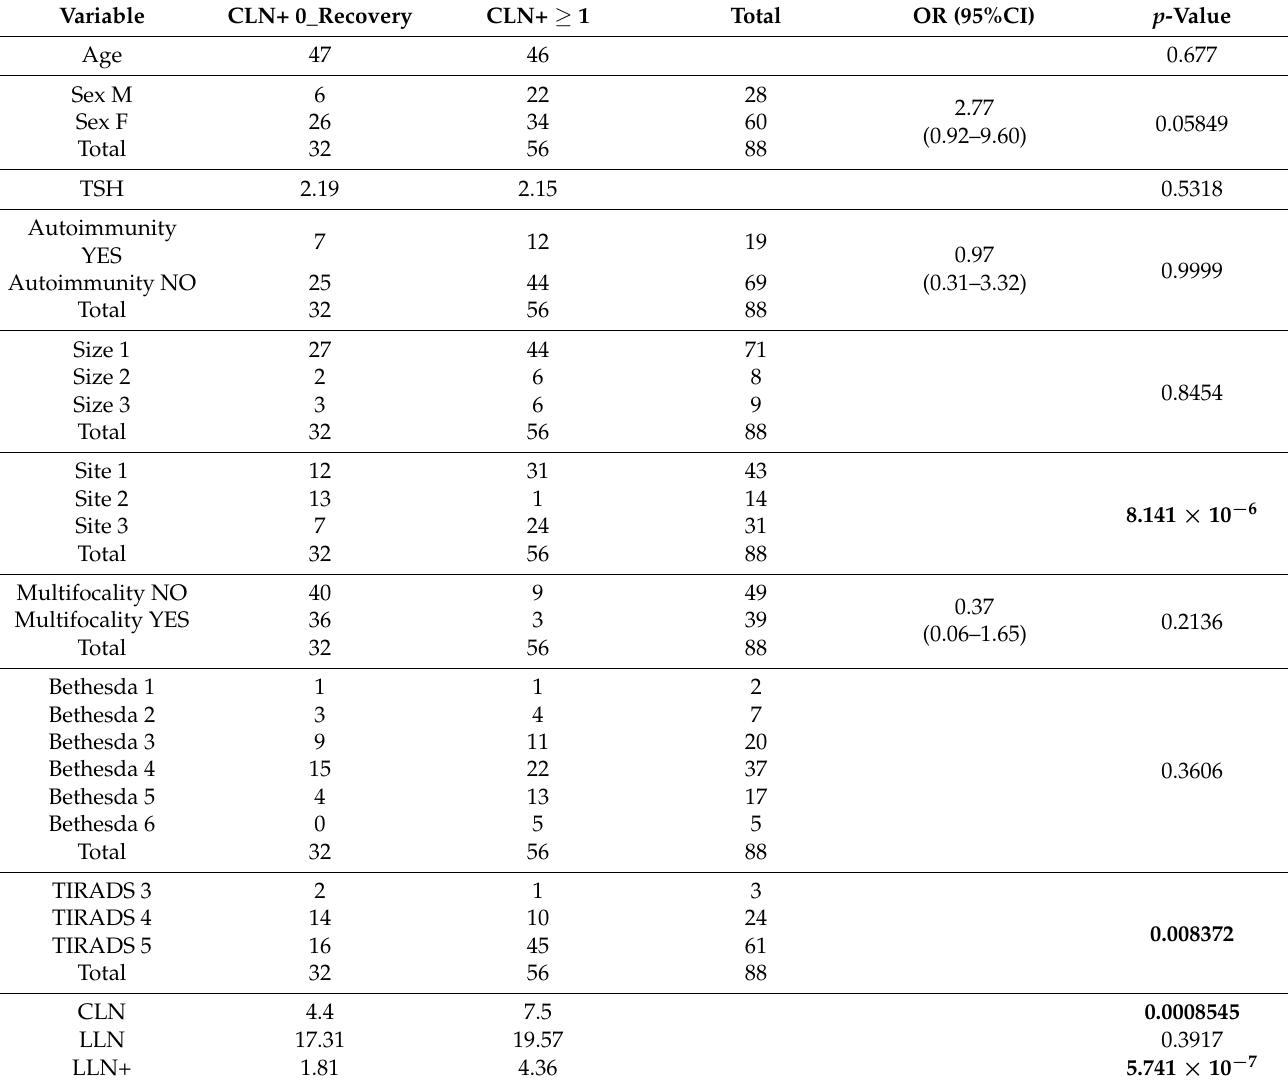
ROC Curves. Bold format of data mean p -Values <